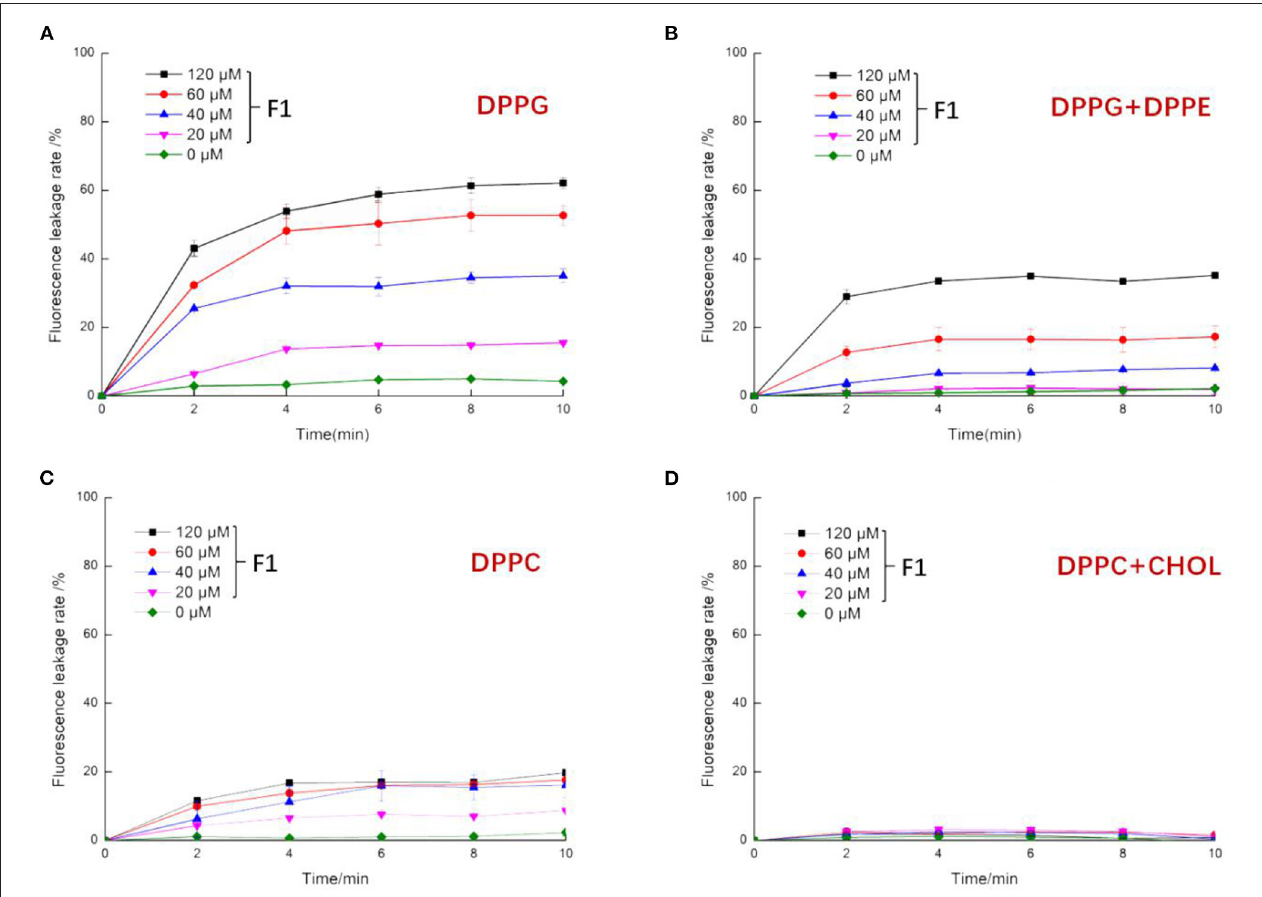
FIGURE 4 | The effect of antibacterial peptide F1 on artificial liposomes. Composition of artificial liposomes was as follows: (A) DPPG (100%), (B) DPPG (30%) + DPPE (70%), (C) DPPC (100%), and (D) DPPC (90%) + CHOL (10%).